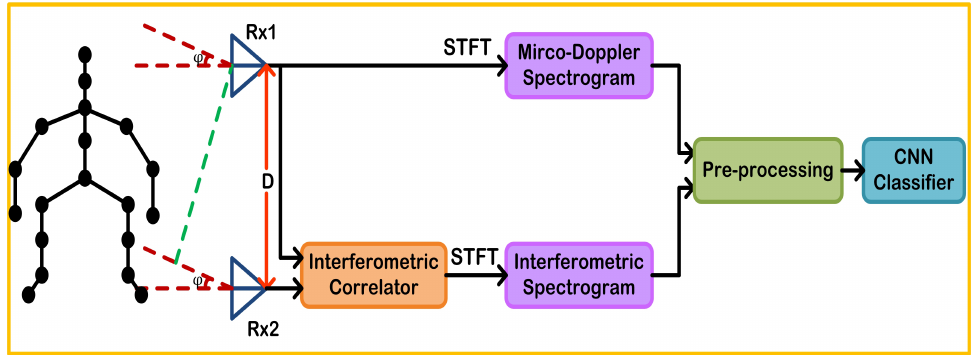
Figure 1. The proposed human activity classification method based on dual micro - motion signatures.